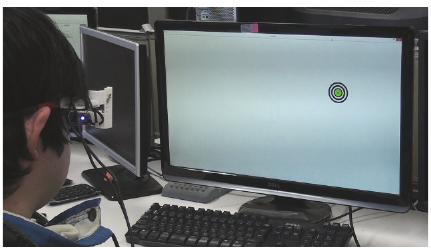
Figure 2: Collection experiment